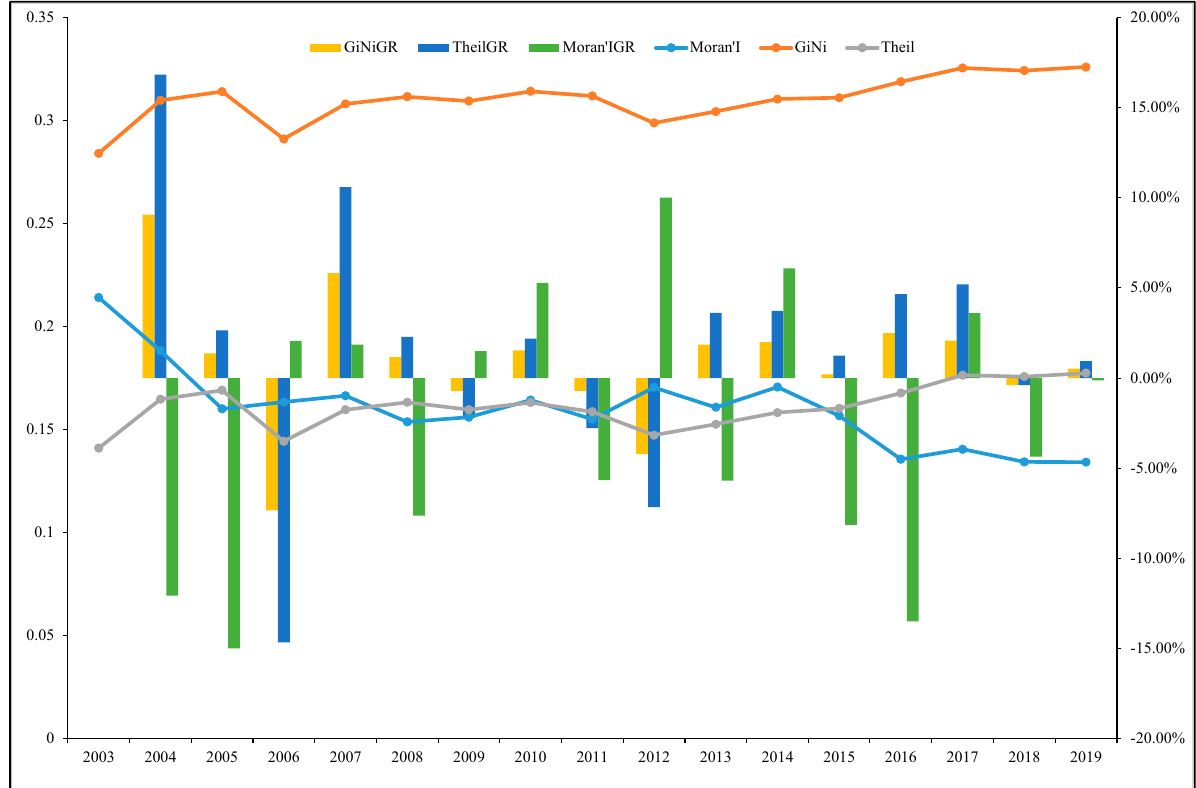
Figure 5. The GINI coefficient, Theil index, Moran I, and their output intensity of agricultural water growth rate.